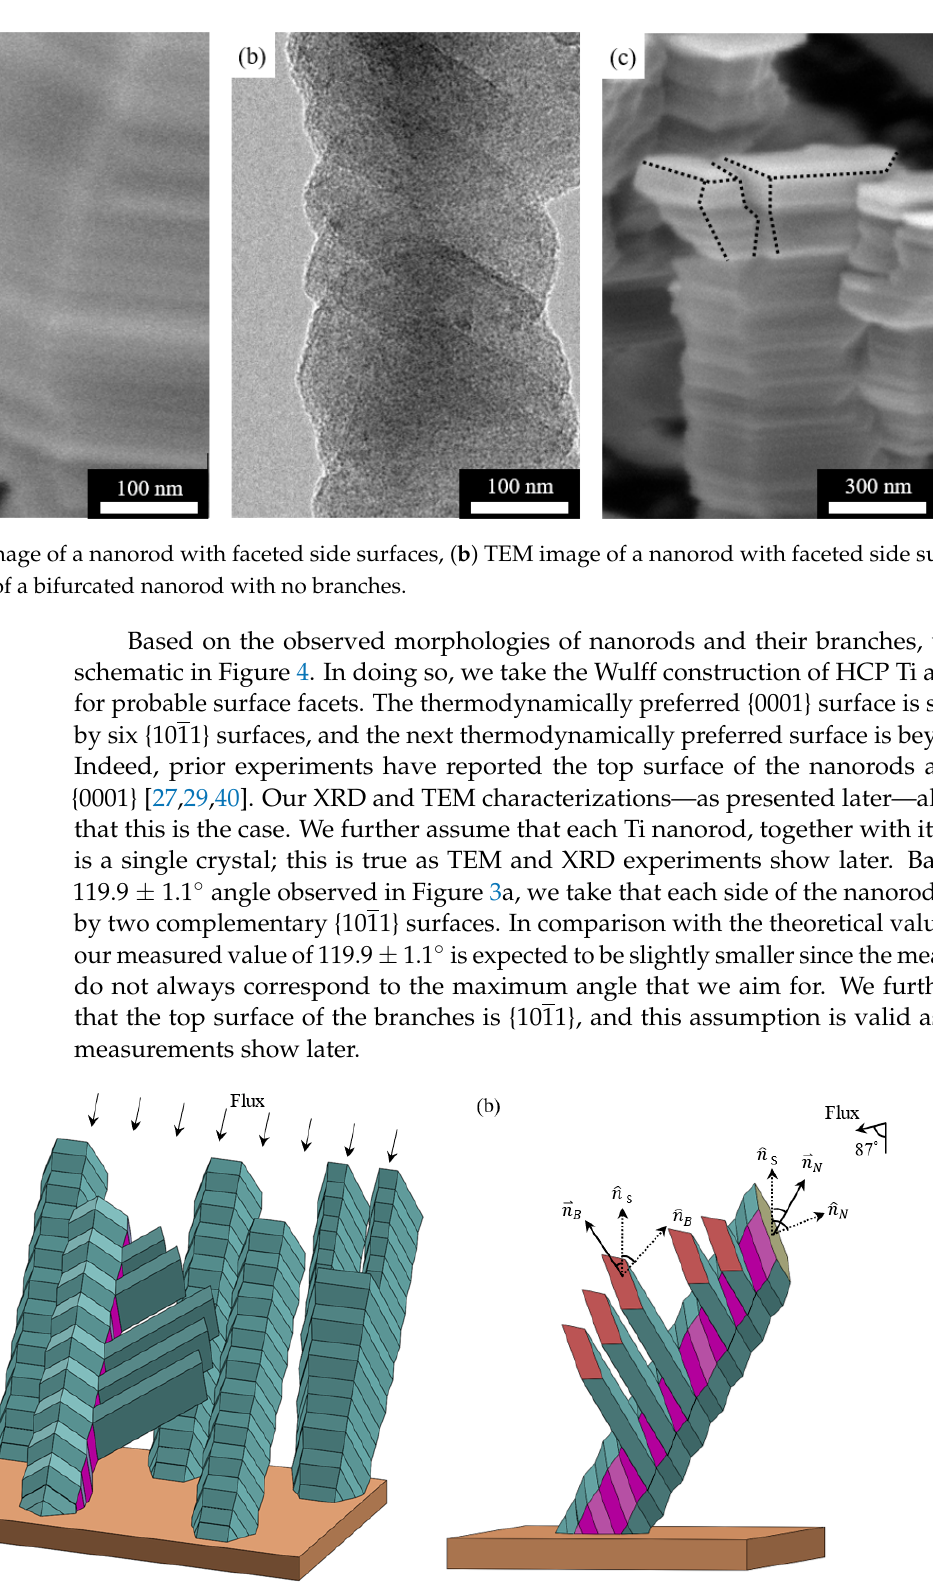
Figure 4. ( a ) Schematic of nanorods, including one with branches, one with bifurcation, and three with no bifurcation or branch; and ( b ) expanded view of the nanorod with branches, with relevant angles of Figure 2 marked, where 𝑛(cid:3548) (cid:3003) , 𝑛(cid:3548) (cid:3020) , 𝑛(cid:3548) (cid:3015) are the surface normal directions of the branch top, substrate and nanorod top, respectively while 𝑛(cid:4652)⃑ (cid:3003) , 𝑛(cid:4652)⃑ (cid:3015) are the axial direction of the branch and nanorod.